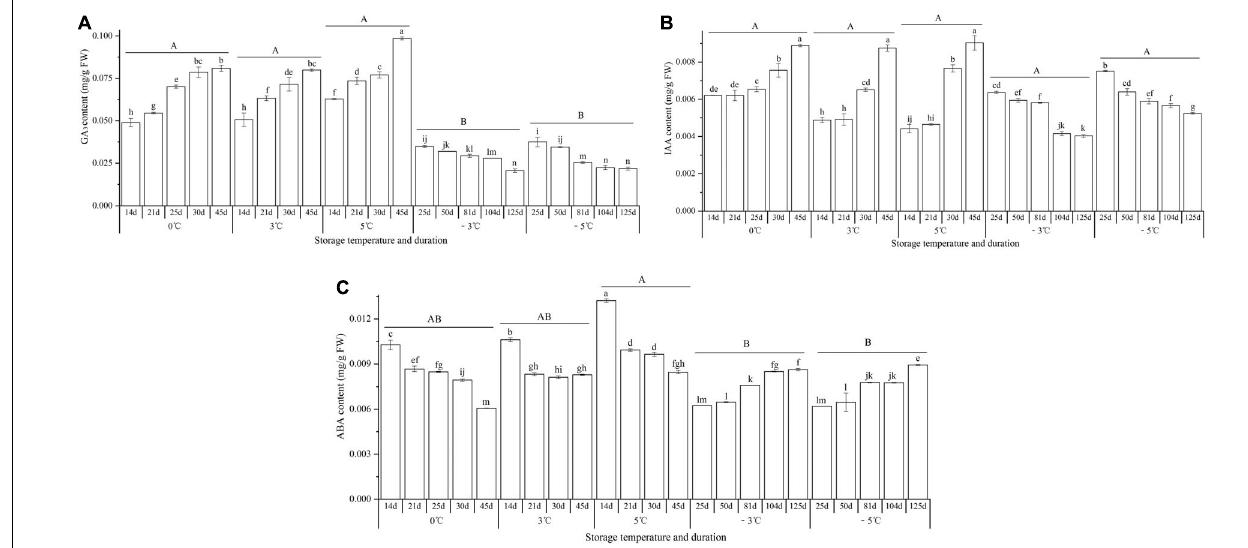
FIGURE 9 | Changes in the contents of GA 3 , IAA, and ABA of seedlings at different storage temperatures and durations. Panels (A–C) represent the contents of GA 3 , IAA, and ABA, respectively. n = 10 per stage for the different size seedlings. Different uppercase letters represent a significant difference ( P < 0.05) in the average value of different storage durations for the medium seedlings among different temperatures. Different lowercase letters represent a significant difference between the storage durations for the same